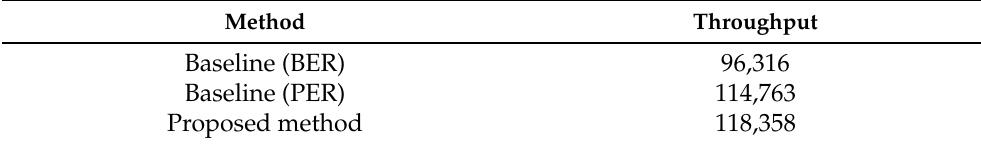
Table 7. Throughput of Different Methods.